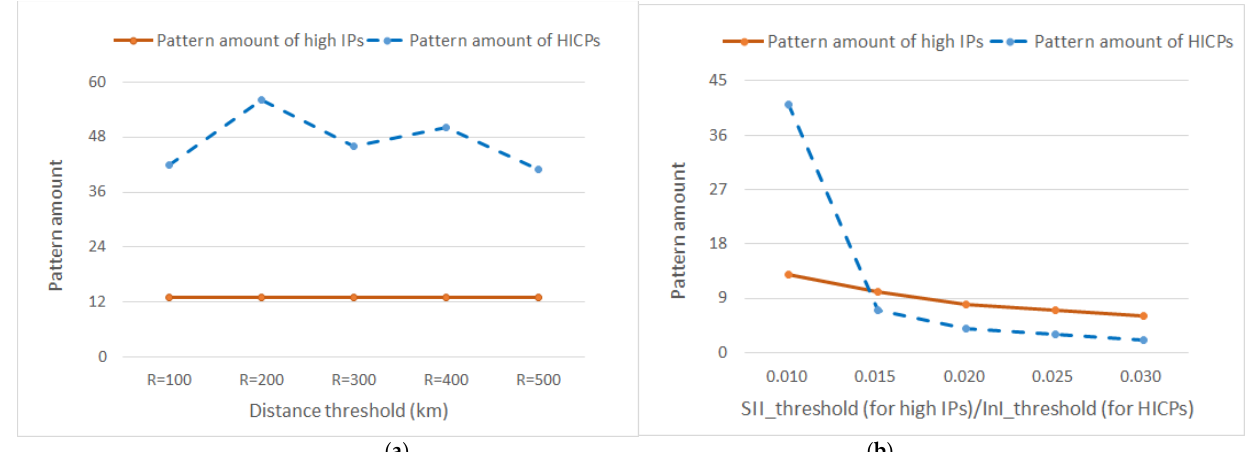
Figure 7. ( a ) Effect of distance threshold on pattern amount on the Real-1 dataset; ( b ) effect of SII threshold /InI threshold on pattern amount on the Real-1